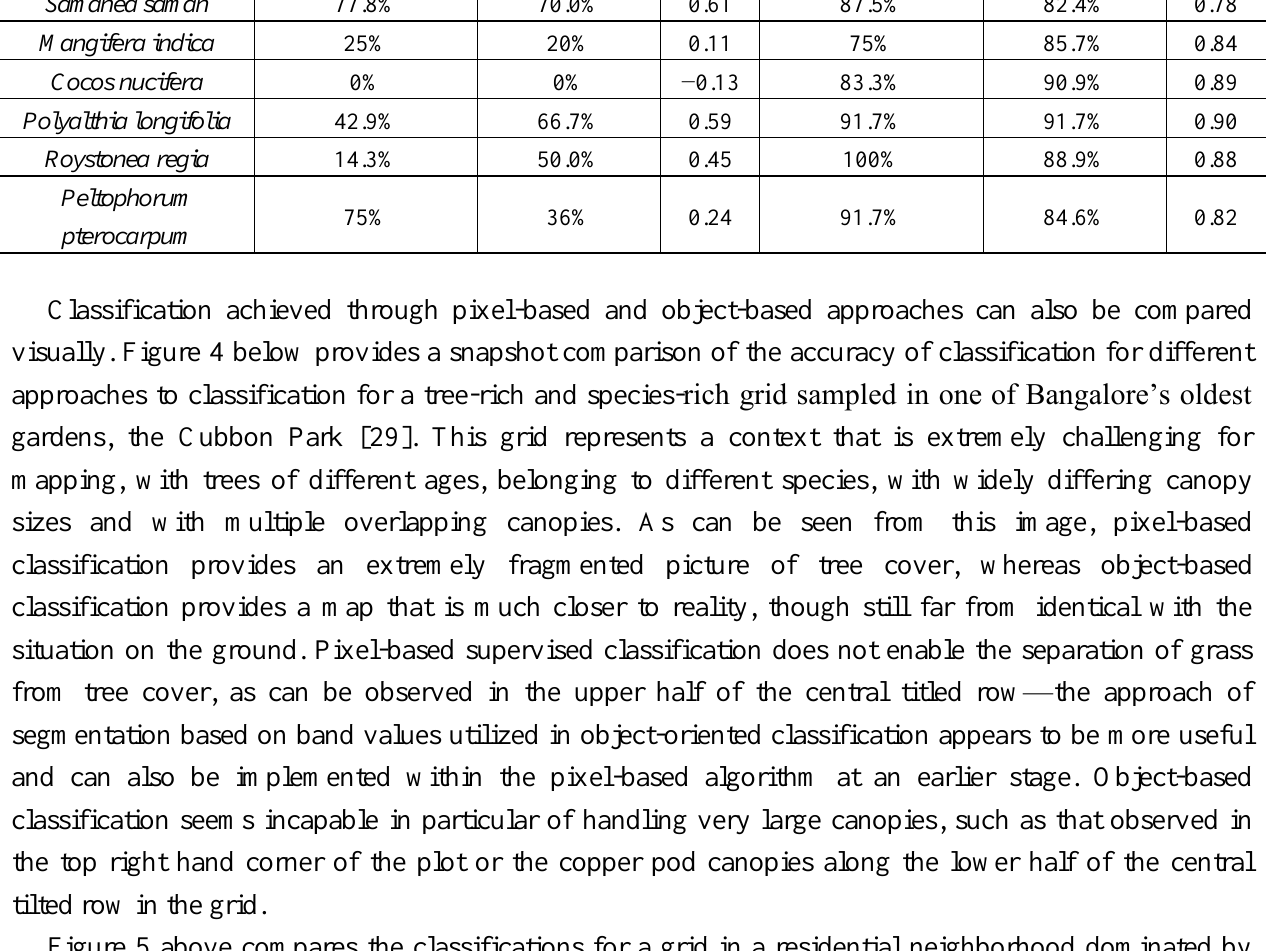
Table 3. Summary of accuracy assessment results for pixel-based and object-based classifications. Pixel-Based Classification Object-Based Classification Producer’s User’s Producer’s User’s Kappa Kappa Accuracy Accuracy Accuracy Accuracy Samanea saman 77.8% 70.0%